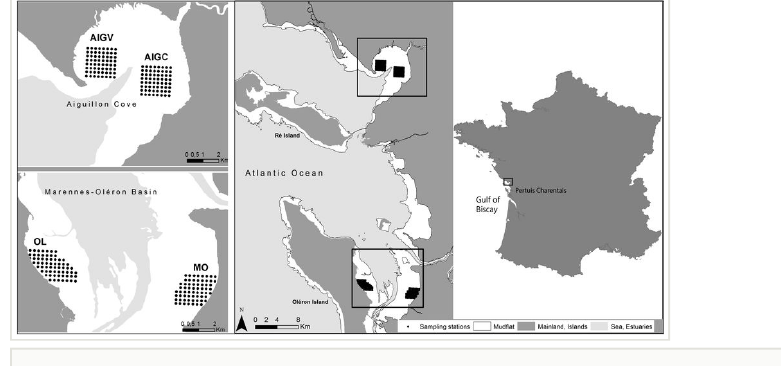
species: the red knot Calidris canutus and the dunlin Calidris alpina (Fig. 2). We took an additional core (70 mm diameter) covering 1/263 m² to a depth of 4 cm for sampling exclusively the very abundant mudsnail Hydrobia ulvae (Pennant) (Bocher et al. 2007). When the tide covered the mud fl ats with water (0.4–2.0 m) and for the very soft and inaccessible lower intertidal areas, sampling was done from boats using in fl atable zodiacs or other small vessels. From the boats, two mud cores (100 mm diameter) covering a total of 1/56 m² to a depth of 20 to 25 cm were taken. Only one core was taken into account for H. ulvae , and both were taken into account for any other macrobenthic species.